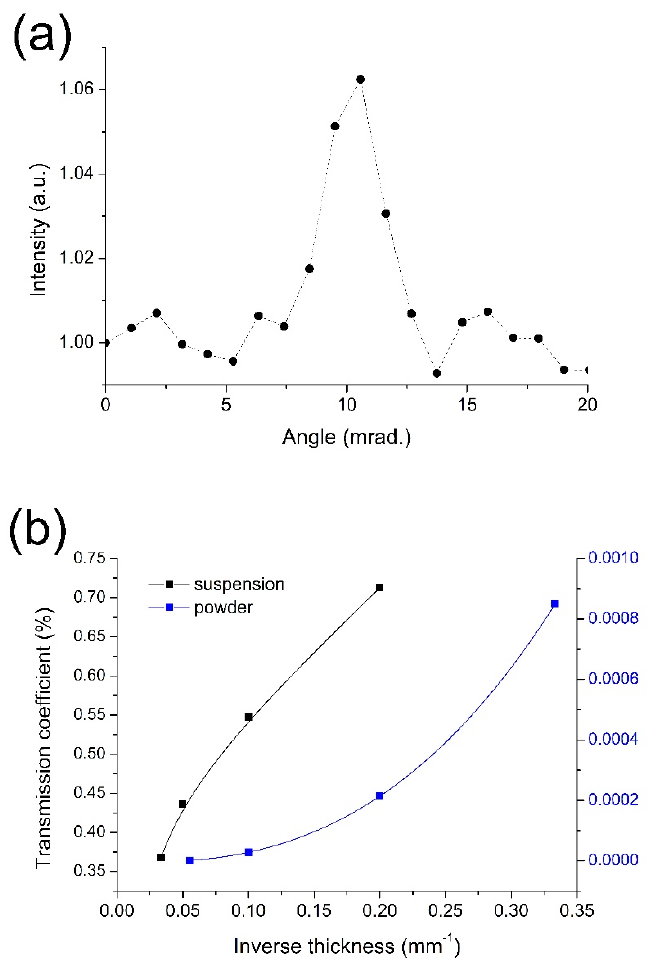
Figure 4. Backscattering intensity as a function of angle for LN powder ( a ); transmission coefficient dependence on the inverse thickness of samples for liquid suspension and powder ( b ).